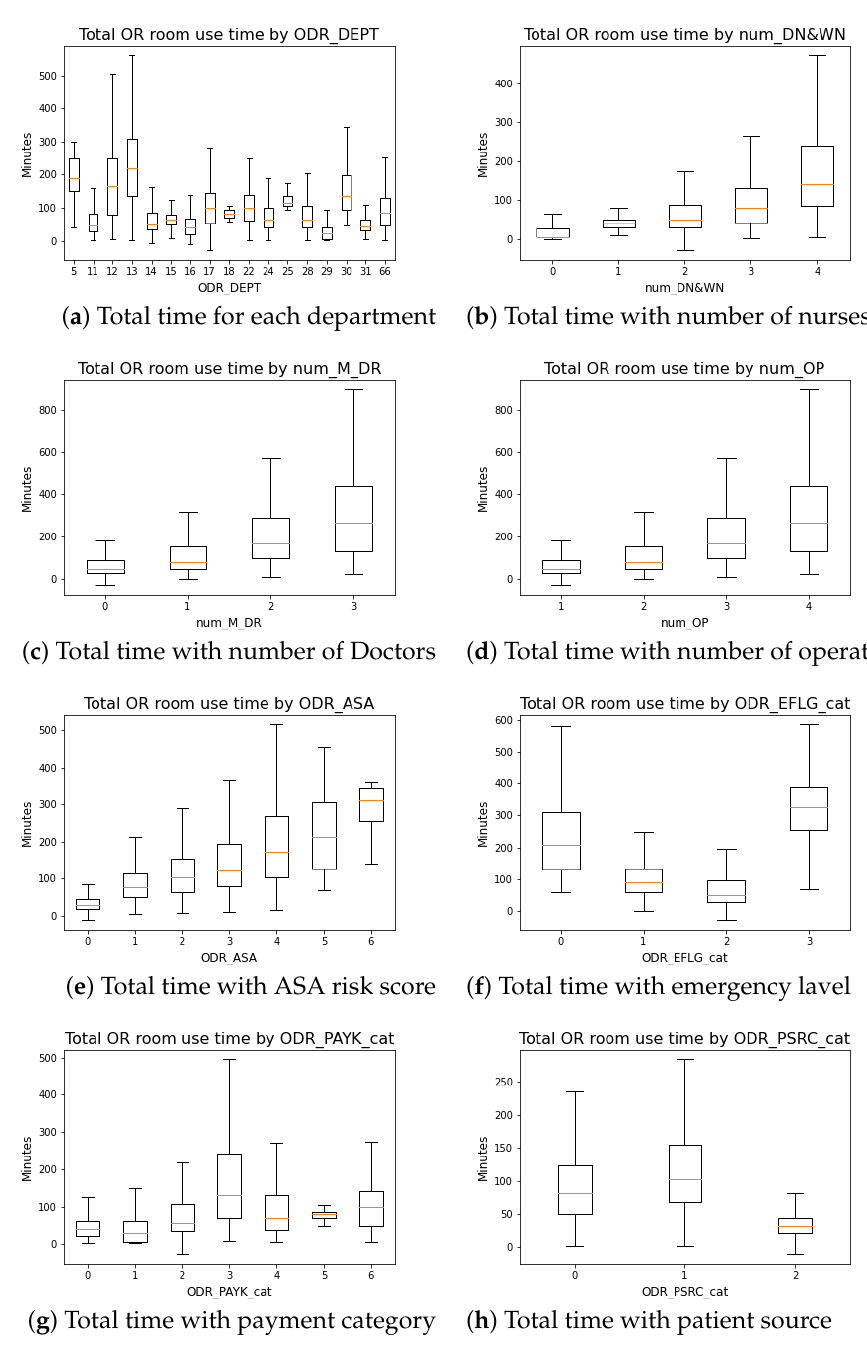
Figure 1. Feature